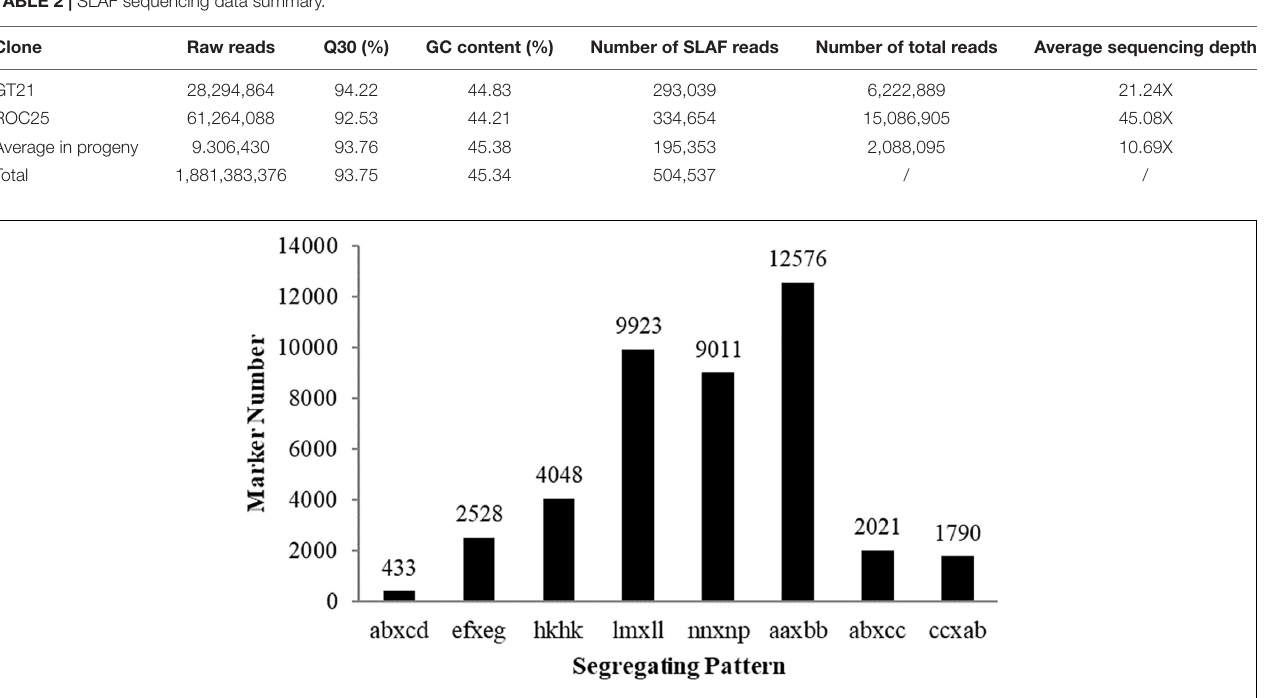
FIGURE 1 | The distribution of smut resistance reaction in sugarcane varieties GT21 and ROC25 (parental clones) and their F 1 progeny (192 clones, mapping population) across four trials conducted over 4 years (2015–2018). Sugarcane varieties NCo310, NCo376 and F134 were included as control. Clone smut response reaction was graded according to a 1–9 rating scale (1 = highly resistant; 2 and 3 = resistant; 4 = moderately resistant; 5 = moderately susceptible; 6 and 7 = susceptible; 8 and 9 = highly susceptible). TABLE 2 | SLAF sequencing data summary.